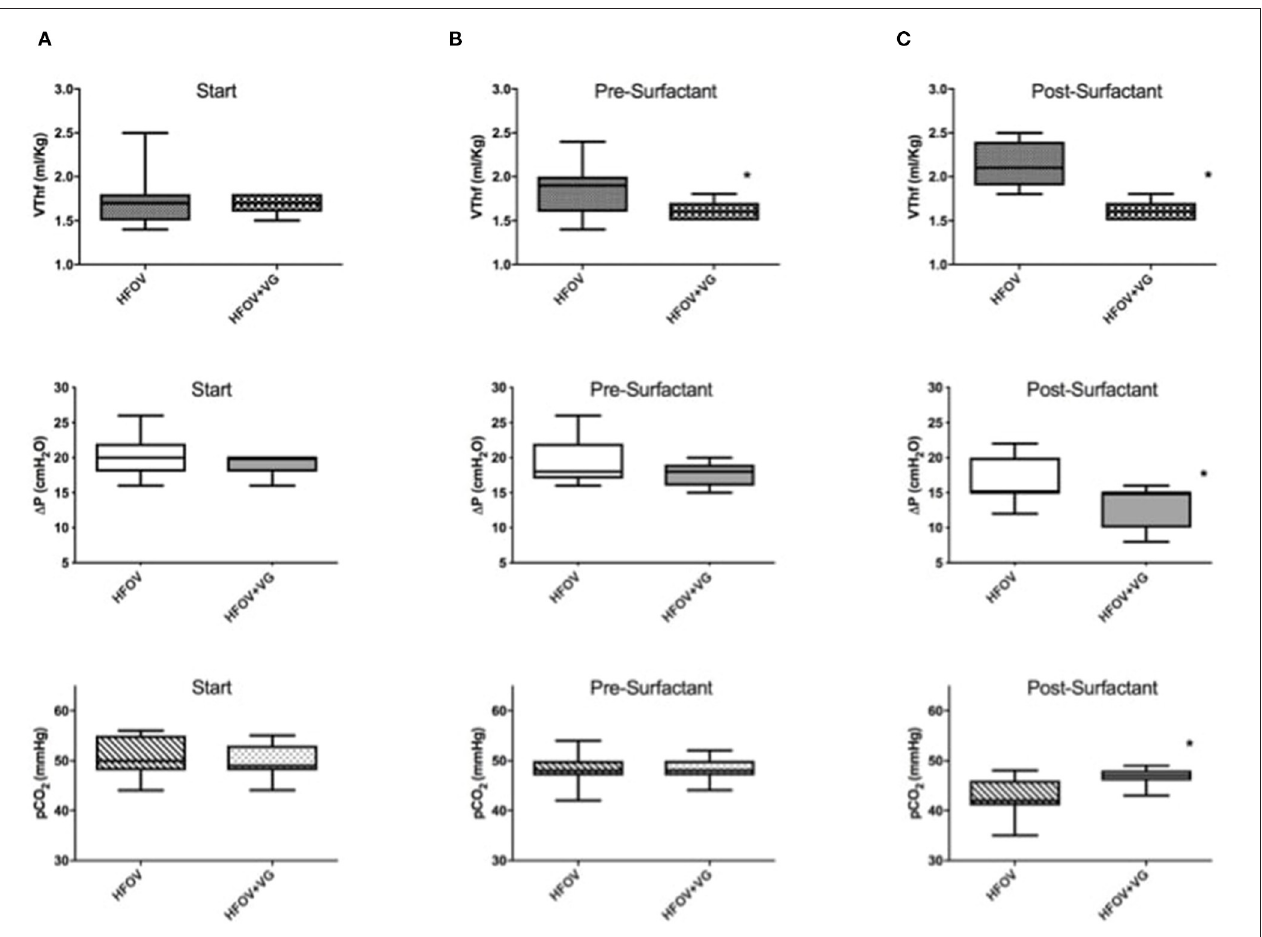
FIGURE 2 | Evaluation of VT hf (ml/kg), amplitude level ( 1 P) and pCO 2 in HFOV and HFOV + VG groups. (A) At start: no significant differences of the three parameters between the two groups were observed. (B) Pre-surfactant administration (after completing the lung recruitment maneuver): there is a significant difference between the two groups in terms of VT hf /kg ( p = 0.03). (C) Post-surfactant administration: there are significant differences between the two groups in terms of VT hf /kg ( p < 0.0001), 1 P ( p = 0.005), and pCO 2 ( p = 0.006). *Represents statistically significant